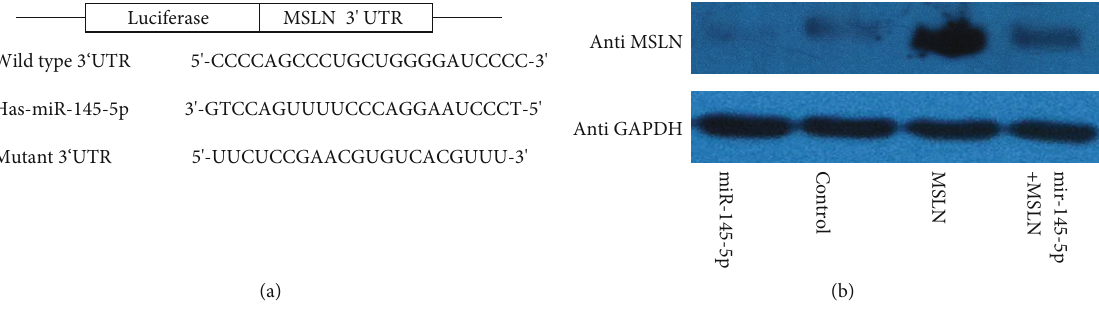
Figure 5: The addition of mir-145-5p inhibits MSLN protein expression in vitro. (a) Sketch of the construction of cDNA3.1-MSLN and miR-145-5p mimics. (b) Western blot results showed that in colo320 cells, the expression of MSLN protein was signi fi cantly increased in MSLN group, but it was inhibited in mir-145-5p and mir-145-5p+msln groups.